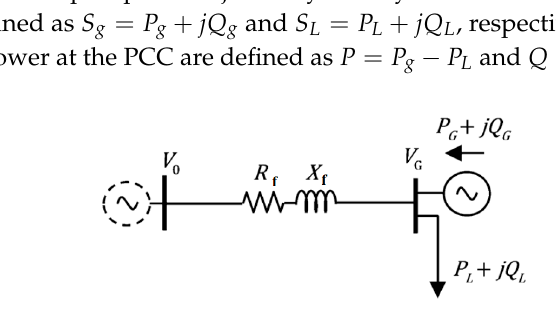
Figure 2. Feeder model with PV [3].